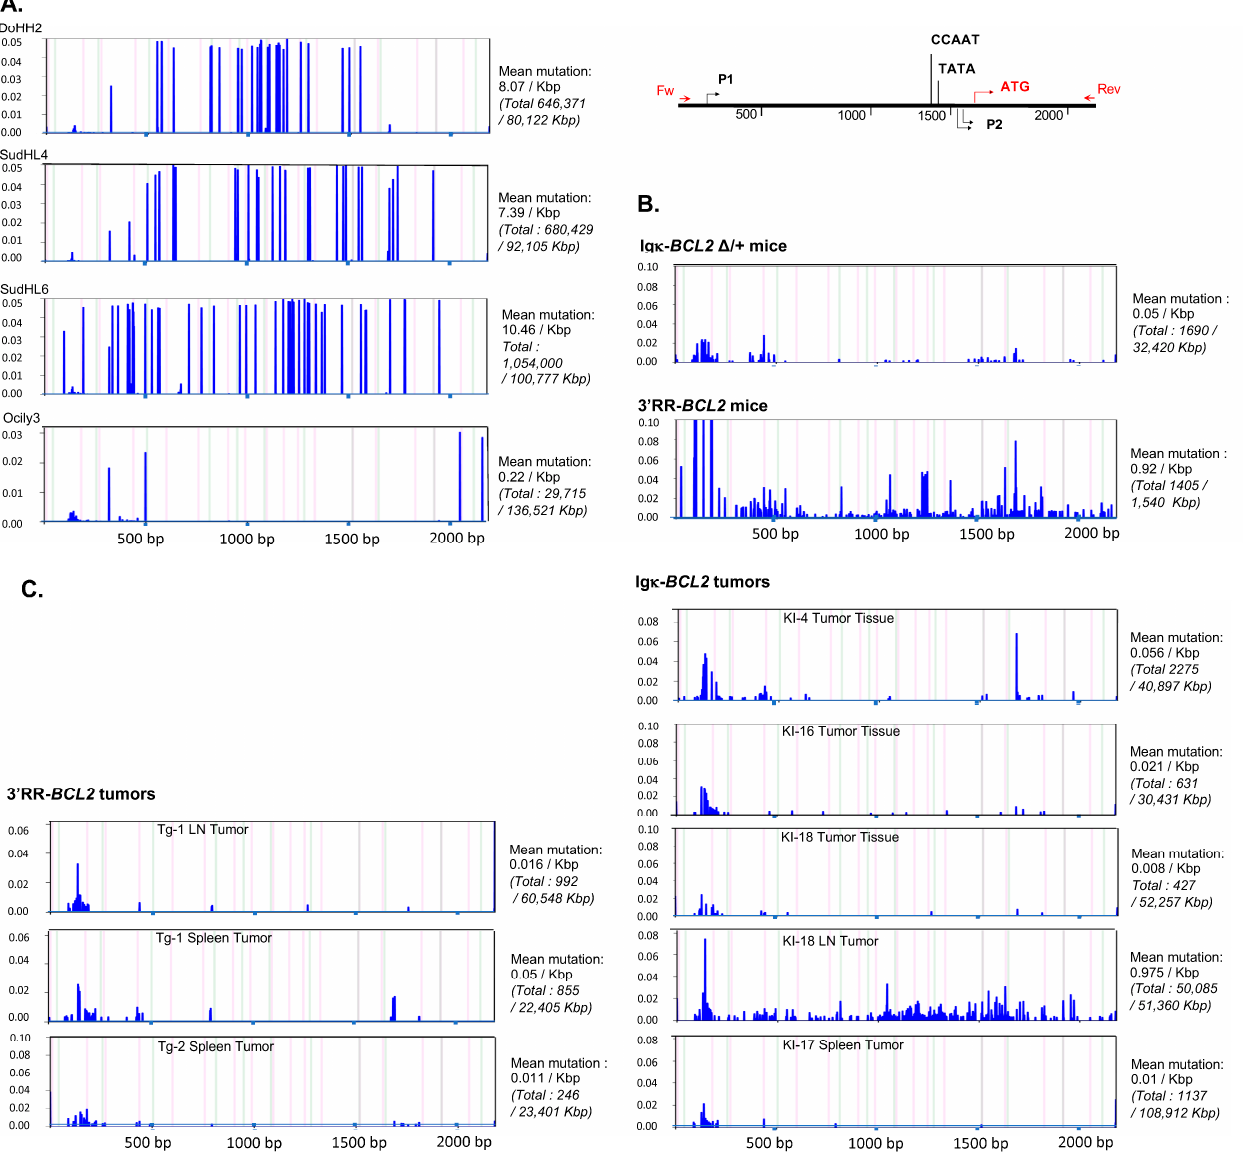
Figure 8. Mutation in the Bcl2 promoter region. Graphs showing the frequency and the localiza- tion/distribution of mutations along the BCL2 promoter region (after high-throughput sequencing) as well as the global mutation rate and the mutation enrichment in AID-hotspots in several human DLBCL cell lines as positive controls ( A ), in total splenocytes or class-switched versus non-class- switched splenocytes of immunized mice (3 iterative immunizations or single 7-day immunization, respectively) from both BCL2 models ( B ) and finally in various tissues/organs from several tumoral mice of both BCL2 models ( C ). Graphs are shown as generated by the system Deminer after correction with respect to two negative controls passed on the same run.